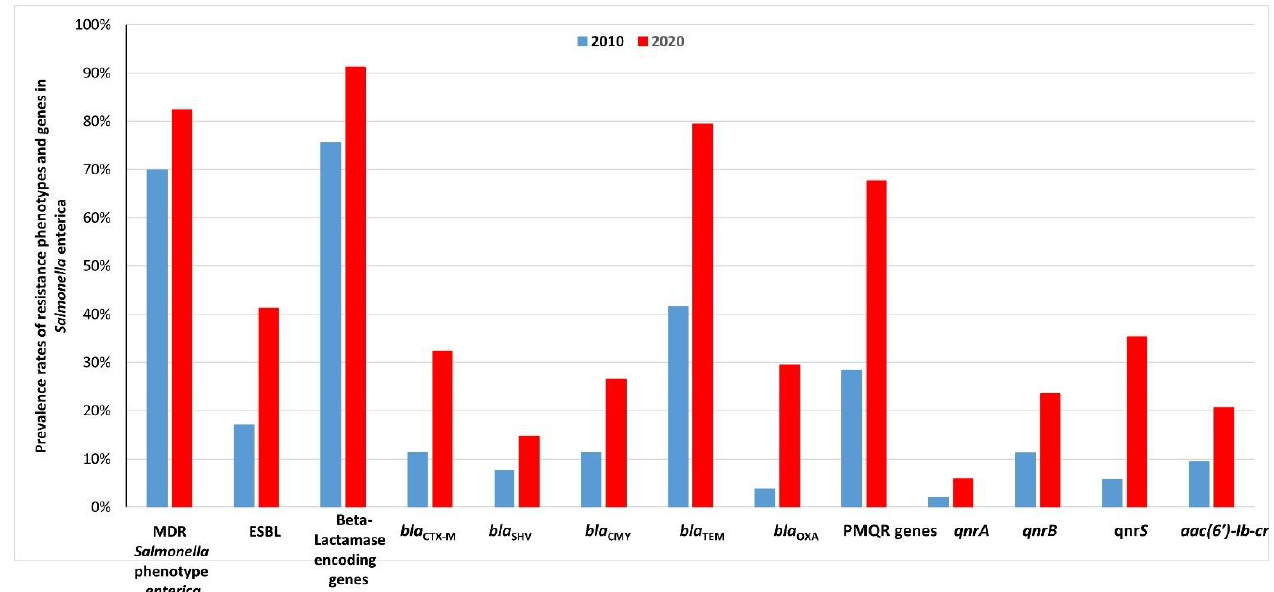
Figure 3. Comparison between the prevalence rates of resistance phenotypes and genes in Salmonella enterica isolated from retail meats and beef carcasses in 2010 and 2020 in Egypt.